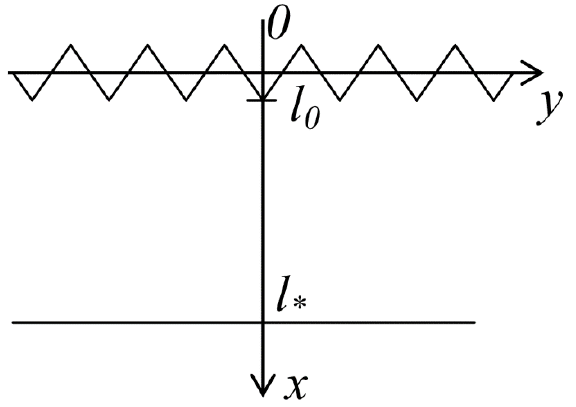
Figure 2. Diagram depicting the microcrack